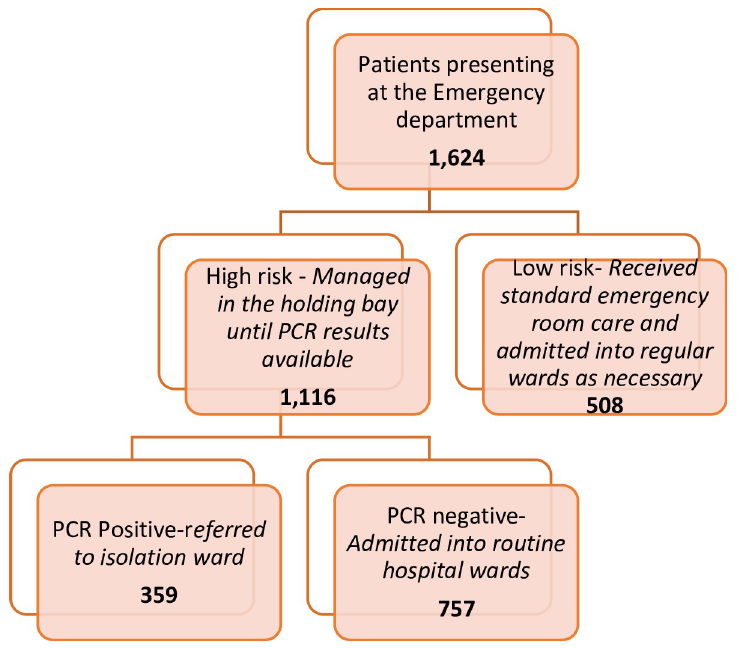
Fig 1. Patient flow in the A&E